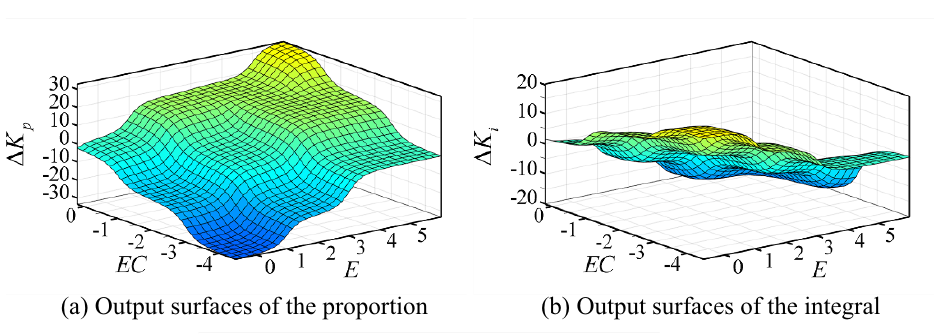
Figure 11. Membership function of fuzzy input variables in ANF PID controller.